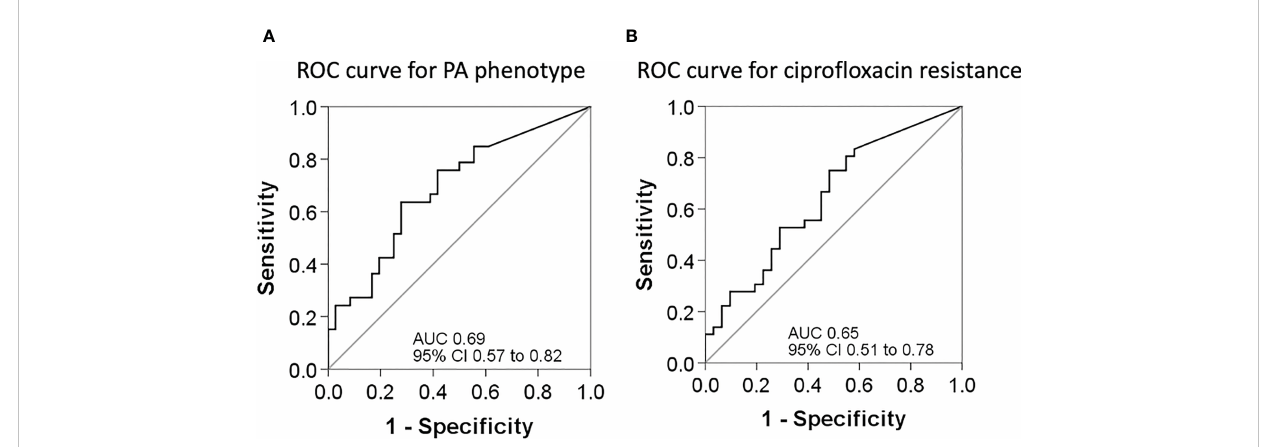
FIGURE 5 ROC curves for sensitivity and speci fi city. (A) ROC curve to assess the best cut-off point of the BPI for PA phenotype determination. (B) ROC curve to assess the best cut-off point of the BPI for PA resistance to cipro fl